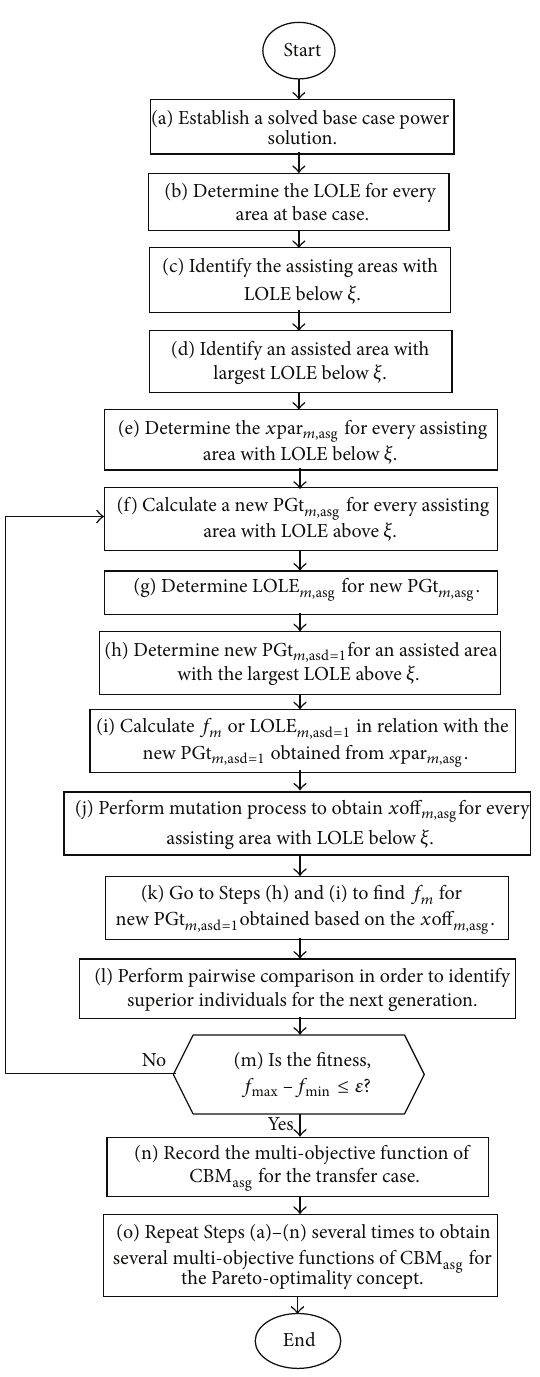
Figure 1: Proposed EP technique to determine several multiobjec- tive functions of CBMs.